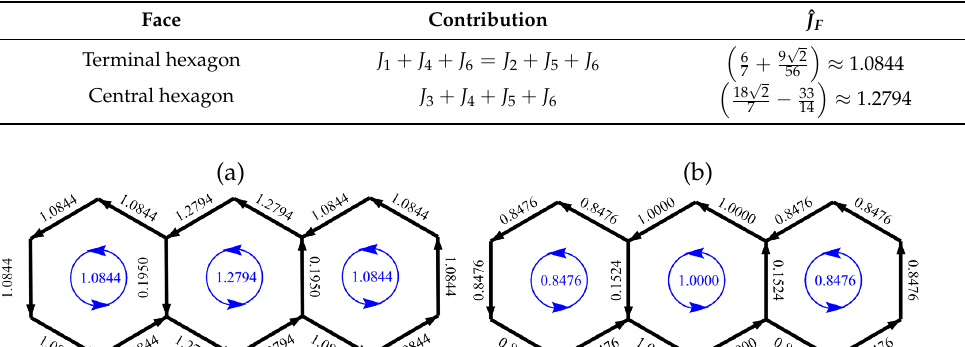
Table 4. Ring currents, ˆ J F , for the terminal and central rings of anthracene, calculated using the cycle currents from Table 3. Currents are given in units of the ring current in benzene. Cycles are labelled as shown in Table 1.